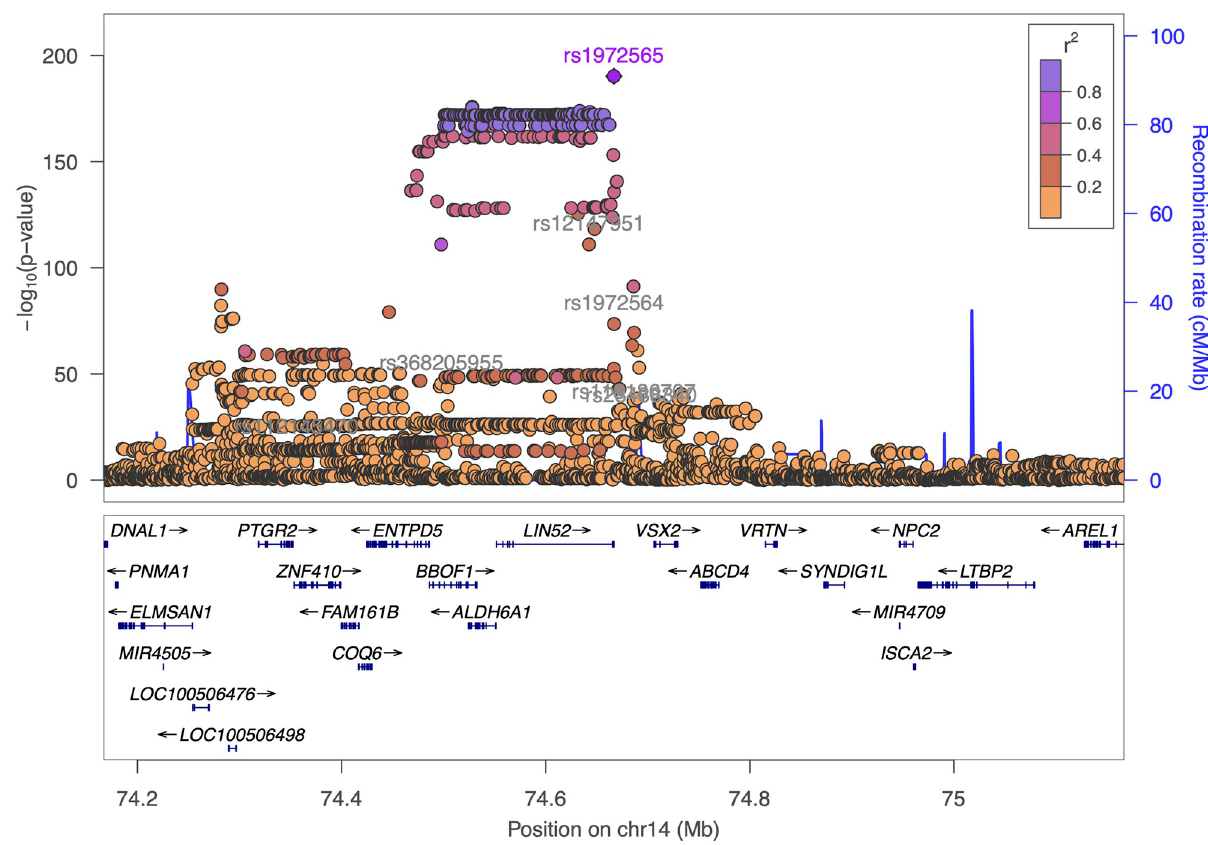
Fig 6. Magnification of the VSX2 locus. Association of the locus on chromosome 14 centred on the genetic variant rs1972565 (highlighted in purple). Other genetic variants found significantly associated with PRC thickness are labelled in grey.